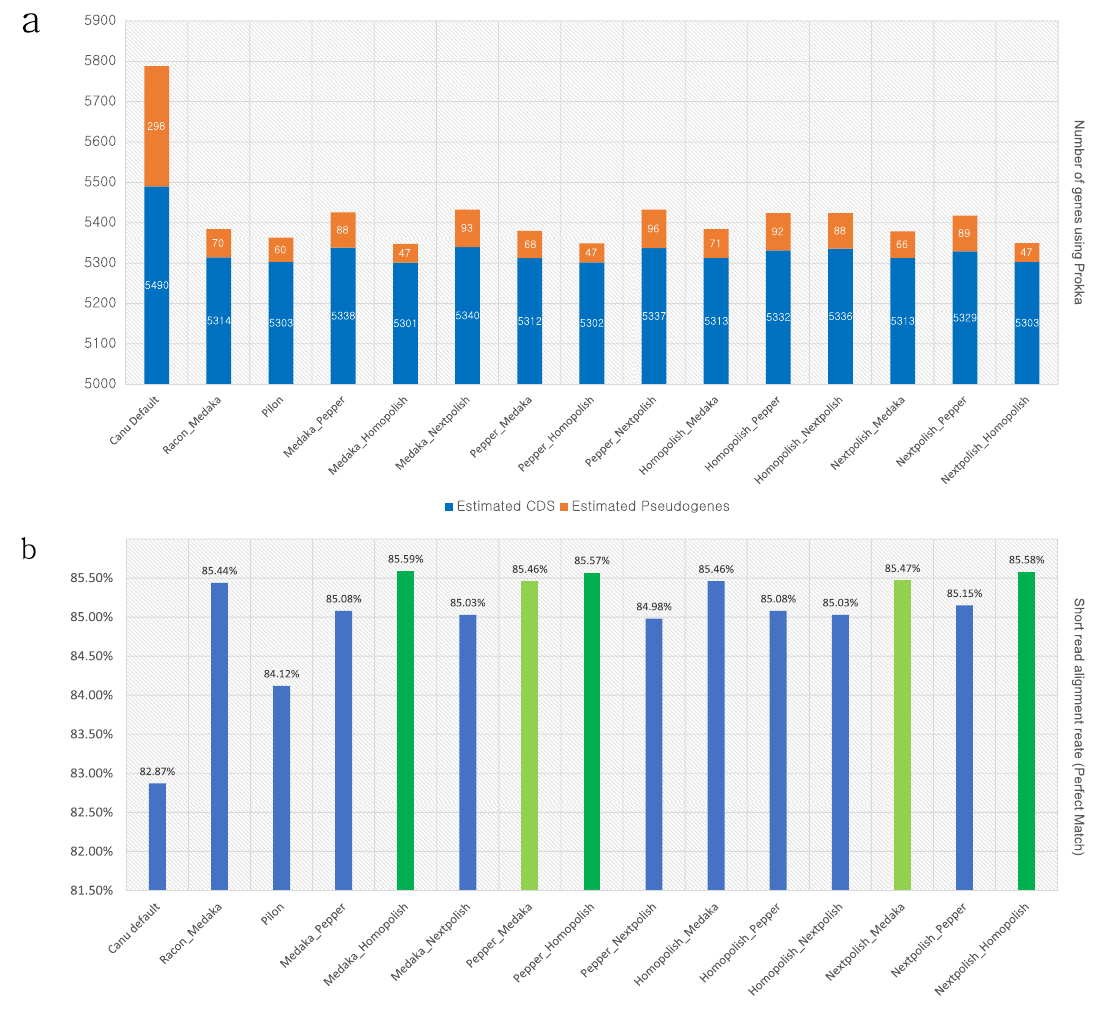
Figure 5. Gene prediction result using Prokka and exact read alignment rate using bowtie2 for each polishing combination. ( a ) Number of predicted genes and estimated pseudogenes using Prokka. ( b ) Alignment rate of perfect matched Illumina short-reads to the polished genome.